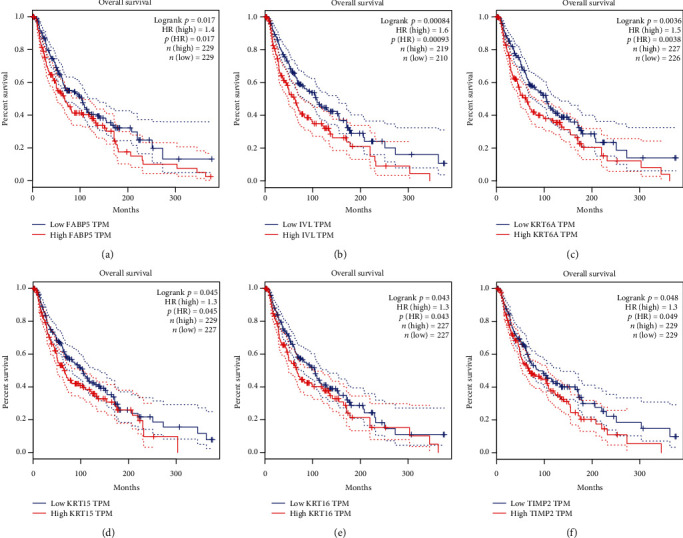
Univariate survival analysis of the hub genes was performed using the Kaplan-Meier curve. The horizontal axis (x-axis) represented time in days, and the vertical axis (y-axis) showed the probability of surviving or the proportion of people surviving. The dotted lines represented the 95% confidence interval information in the survival plot, with high expression marked in red and low expression marked in blue. The lines presented survival curves of two groups. Each elevated expression in 6 hub genes showed markedly significant worse OS in melanoma samples (p < 0.05).